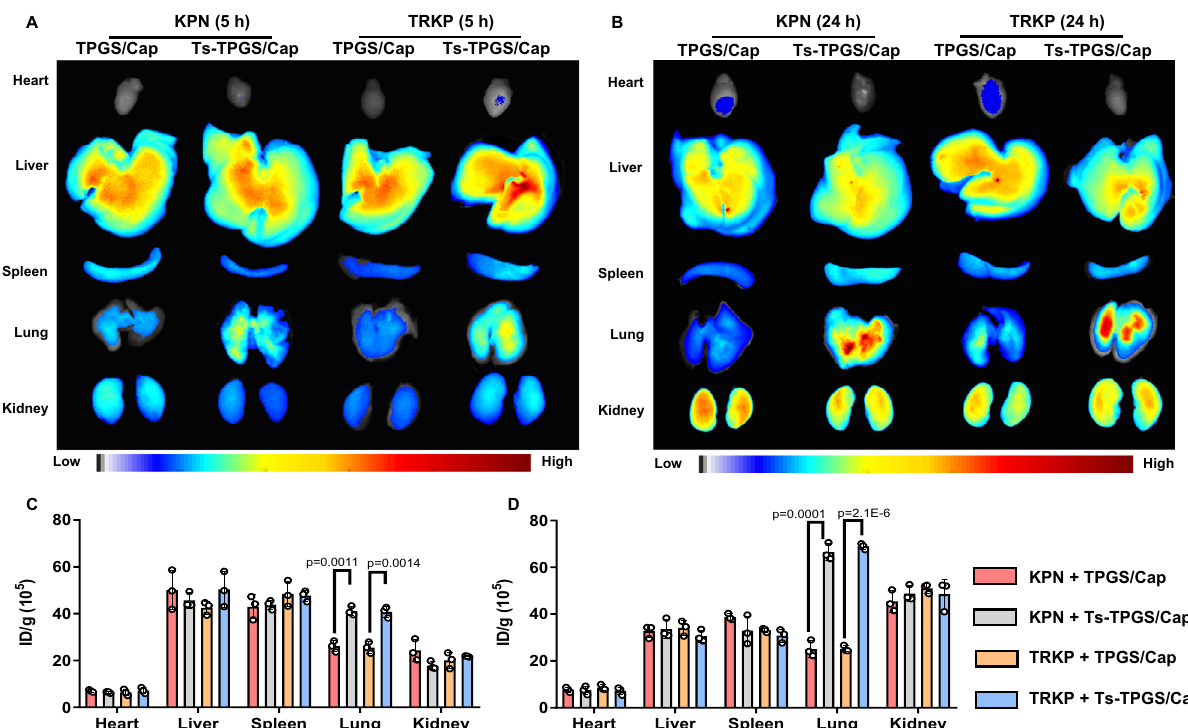
Fig. 6 Evaluation of the biodistribution and targeting ef fi cacy of Ts-TPGS/Cap in vivo. Fluorescence images of major organs collected from KPN- and TRKP-infected mice with pneumonia ( A ) at 5 h ( B ) and 24 h postinjection of TPGS/Cap and Ts-TPGS/Cap nanorods. Semiquantitative analysis of the fl uorescence intensity in major organs displayed in ( C ) Fig. 6A and ( D ) Fig. 6B ( n = 3 mice). Ts-TPGS/Cap Ts-TPGS functionalized calcium phosphate nanorods, TPGS/Cap TPGS-functionalized calcium phosphate nanorods, KPN Klebsiella pneumonia , TRKP tigecycline-resistant Klebsiella pneumonia . Data are shown as the mean ± SD ( n = 3 mice for each group). Unpaired two-tailed T-test was performed in C , D . Source data are provided as a Source Data fi